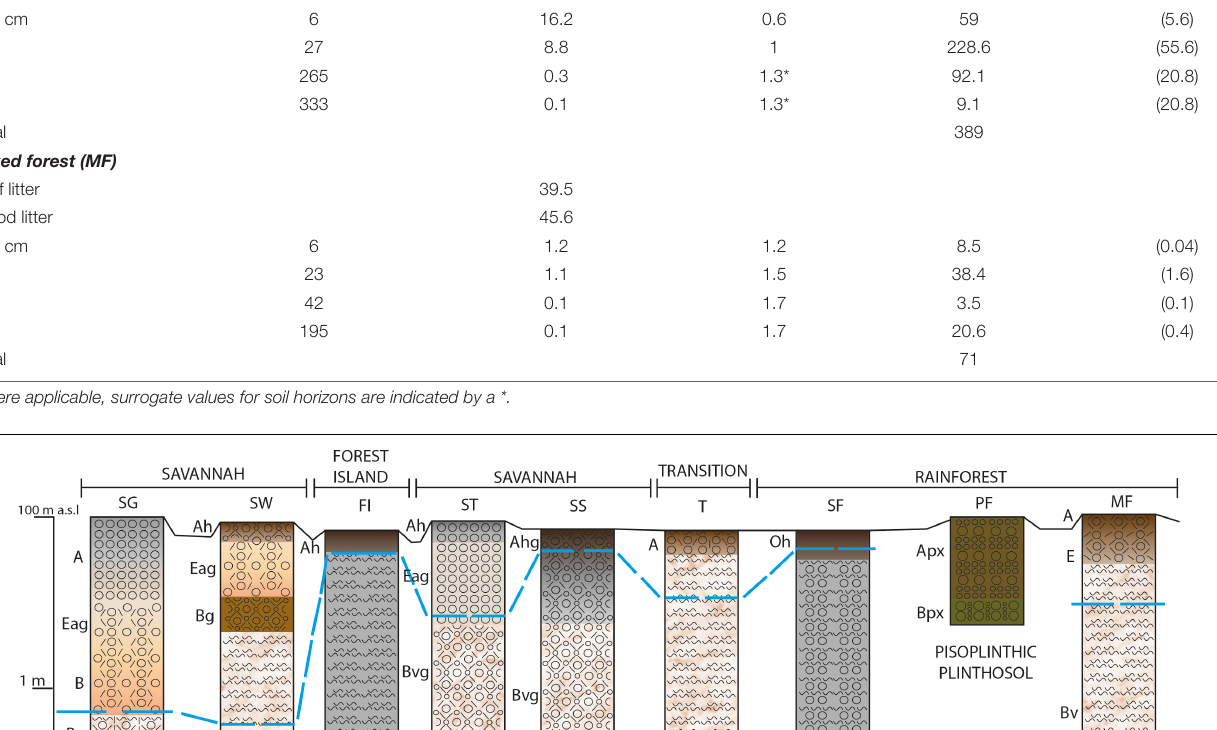
The clay mineral kaolinite is present in all samples tested except for the savannah sites ST and SW. The ferric iron phosphate mineral strengite is also present in all the soils tested, except for SF. Anatase, nepheline, and scapolite are also present in